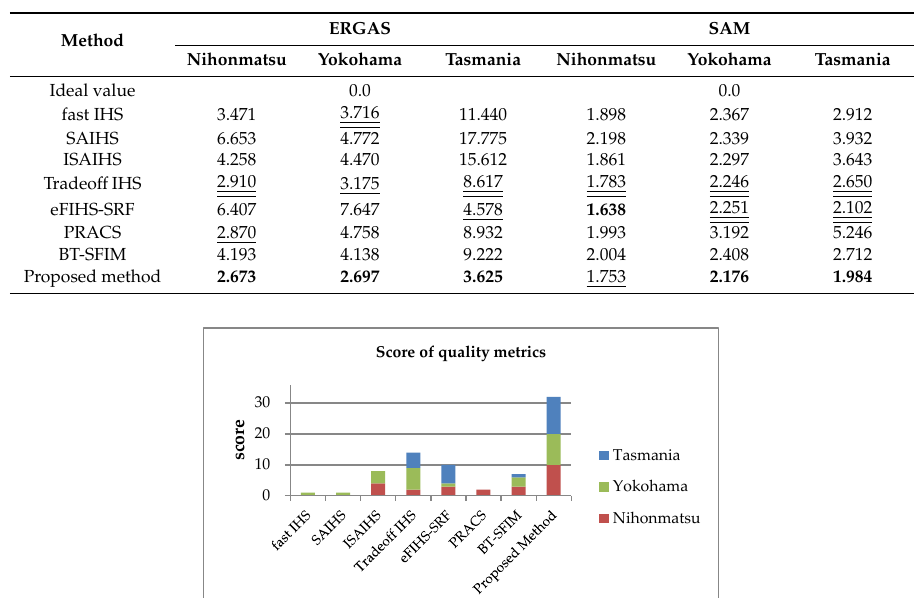
Table 5. Erreur relative globale adimensionnelle de synthese (ERGAS) and spectral angle mapper (SAM) quality metrics results.